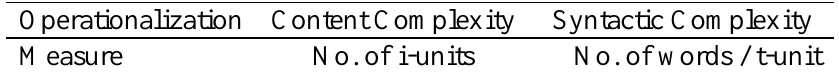
Linguistic Complexity in this